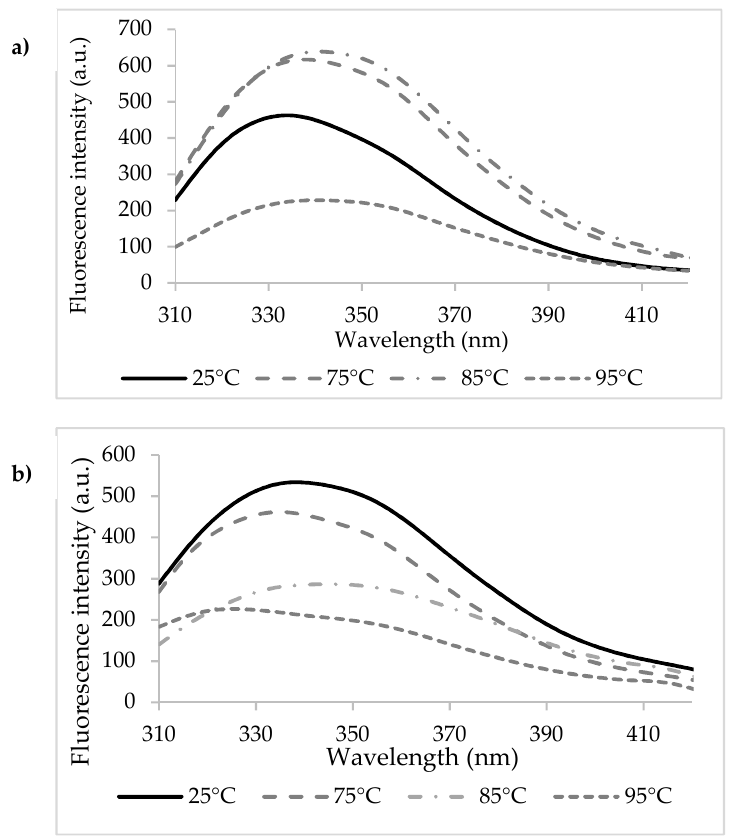
Figure 3. The fluorescence intensity spectra of the heat-treated β -lactoglobulin ( a ) and cross-linked β -lactoglobulin ( b ).